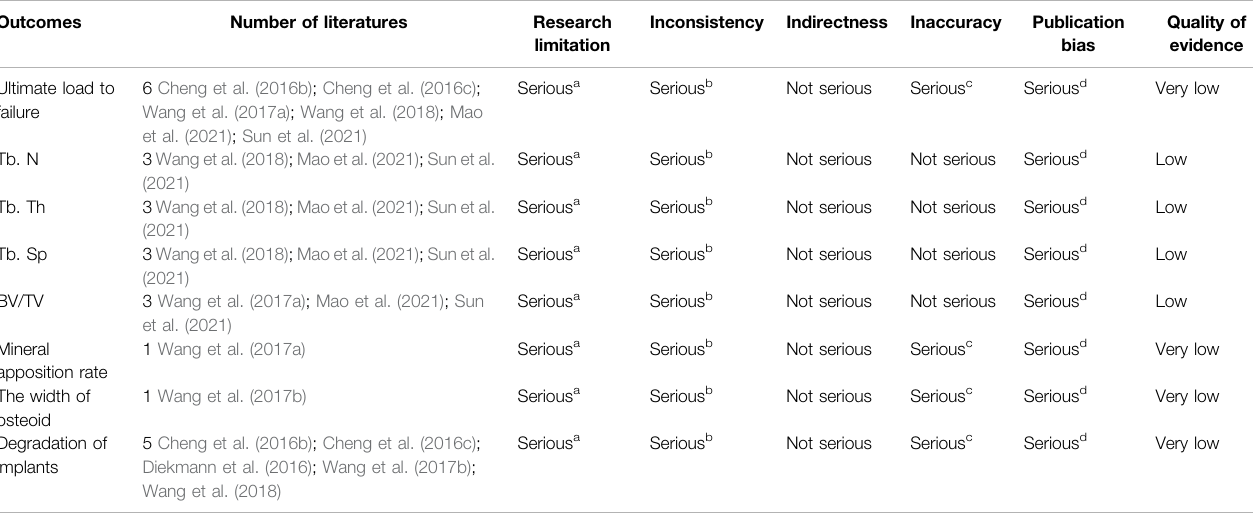
TABLE 2 | Quality of evidence in included systematic reviews with